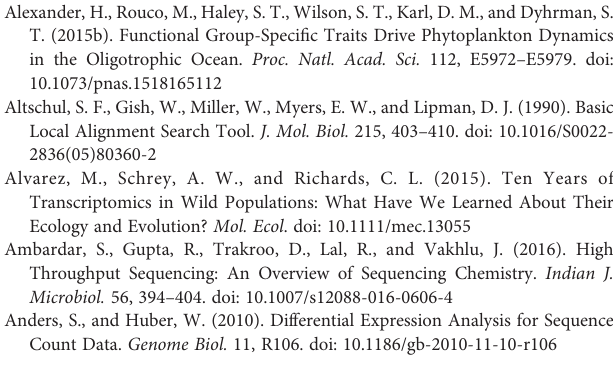
Supplementary Figure 1 | Example research questions and analysis recommendations. The standard bioinformatic work fl ow is used to produce the intermediate products (assembly, annotations, read mappings, etc.), but normalization and visualization strategies differ depending on research question. * Note that either non-normalized raw reads or community-wide TPM may be used for relative community composition visualization with stacked barplots, but normalized counts (taking into account differences in library sizes) is recommended for ordinations. Supplementary Figure 2 | Example MA and volcano plots for visualizing differential expression. MA plot (A) : MA plot shows the mean fold change versus mean expression with both measures on a log 2 scale. Genes above the horizontal dashed line represent genes with increased expression in one treatment (numerator in the fold change calculation) and genes below represent increased expression in the other treatment (denominator in the fold change calculation). Additional modi fi cations can aid in visualizing differentially expressed genes. For example, this plot shows genes that are not signi fi cantly differentially expressed as gray points while genes that are signi fi cantly differentially expressed are black points (P < 0.05). Data points with extremely high fold change values are plotted as triangles rather than circles. In this example, those are genes with log 2 fold change values greater than 5 or less than -5. The size of the points is scaled by -log 10 (p-value) such that lower p-values are larger points. Although not shown here, genes of interest can be color-coded and/or labeled directly if desired. One simple and popular coloration is to show the signi fi cantly up- or down-regulated genes as two different colors, for example, red and blue respectively. MANTA plot (B) : This plot is a modi fi cation of the MA plot and was introduced by Marchetti et al., 2012. The original plotting function was released as part of the manta (Microbial Assemblage Normalized Transcript Analysis) package in Bioconductor; however, use of this package to generate plots restricts users to use MANTA objects and lacks features such as the ability tohandle replicates. As a result, new plotting functionsinspired by the original were re-written and are available on Github (github.com/AlexanderLabWHOI/2022- metaT-m3-perspective). Here, genes that are signi fi cantly differentially expressed are shown as pie charts rather than plain black circles to display that taxonomic breakdown ofthe genes.Thisexampleusesthe samedata asthe MAplotexample, but now, different diatom genera are shown. Depending on the user ’ s analysis, different groups and/or taxonomic-levels can be used. The use of the triangles as shown in the MA plot was omitted for this plot, but extremely high log 2 fold change valuesare5or-5.Volcanoplot (C) :Ratherthanhighlightingthemeanabundanceof a gene as in the MA plot, the volcano plot emphasizes the statistical signi fi cance (p- value) of genes between two treatments. Here, genes to the right of the horizontal dashed line represent genes with increased expression in one treatment (numerator in the fold change calculation) and genes to the left represent increased expression in the other treatment (denominator in the fold change calculation). Only genes above the horizontal dashed line, -log 10 (0.05) representing a = 0.05, are shown in black while genes below it are shown in gray to distinguish between points that are signi fi cantly differentially expressed or not as in the MA plot. Data points with extremely lowp-valuesand thusarehighonthey-axisareplottedastrianglesrather thancircles.Inthis example,thoseare geneswithP<0.00001.AswiththeMAplot, additional color coding may be performed and may be as simple as coloring all the genes in the left treatment blue and genes in the right treatment red. Genes of interest can also be color-coded and/or labeled directly if